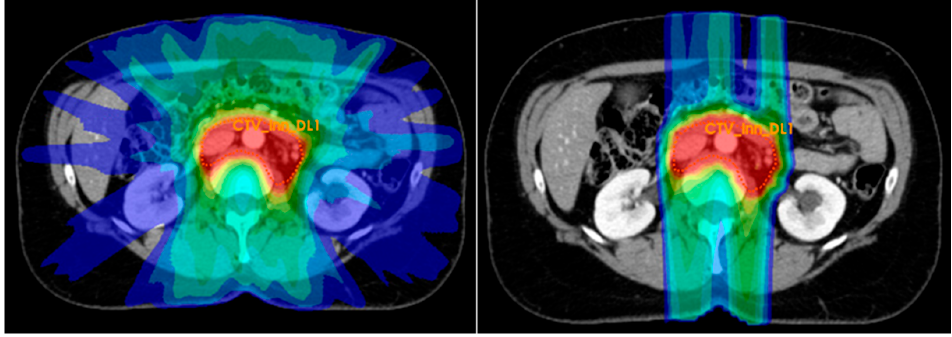
Figure 1. A typical dose distribution for the para-aortic region for IMRT (left) and IMPT (right)